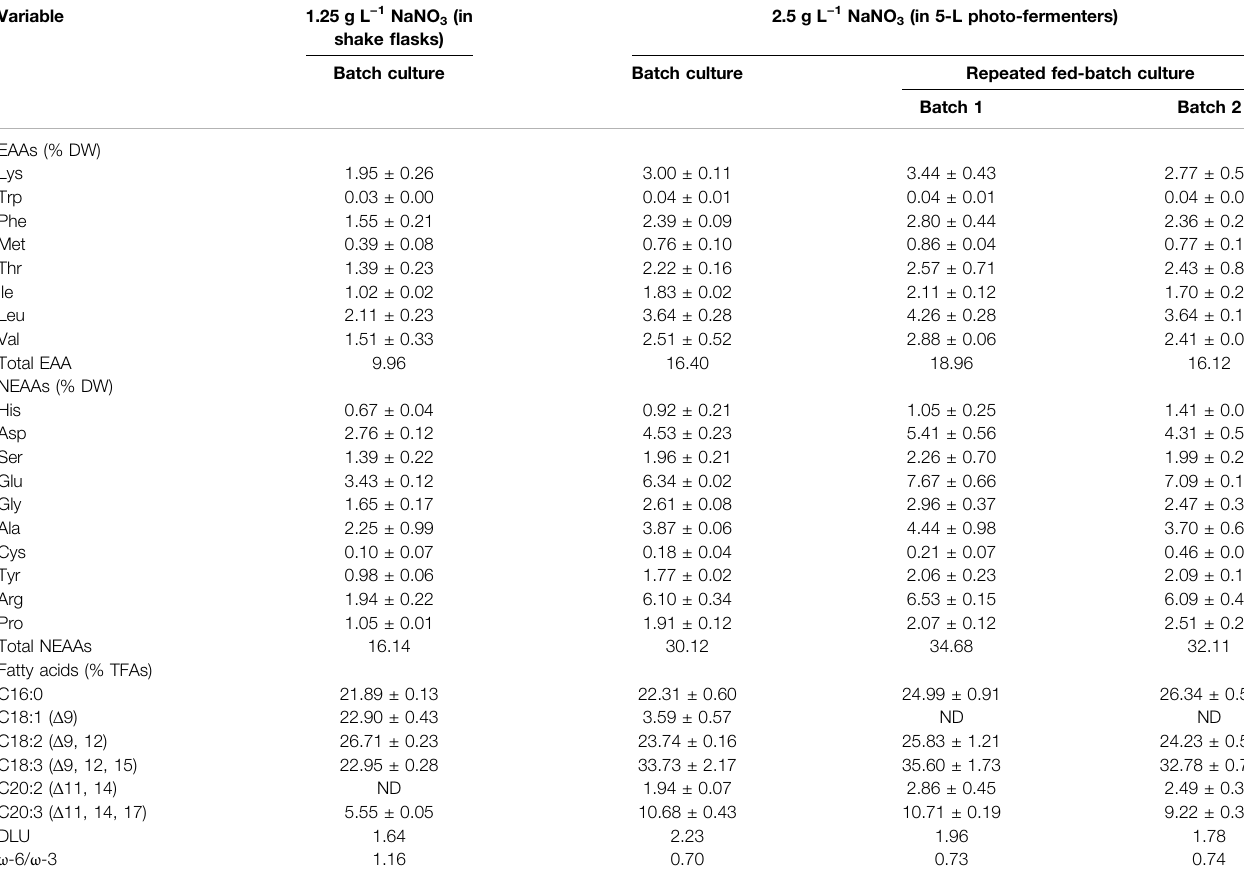
TABLE 3 | Amino acid and fatty acid pro fi les in the fi nally harvested biomass of autotrophic C. subellipsoidea under various nitrate concentrations.